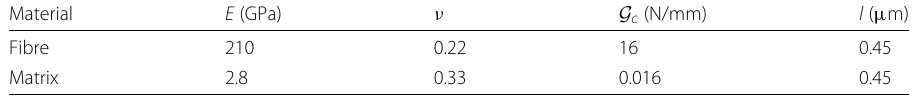
Table 2 Mechanical properties: fibre and matrix Material